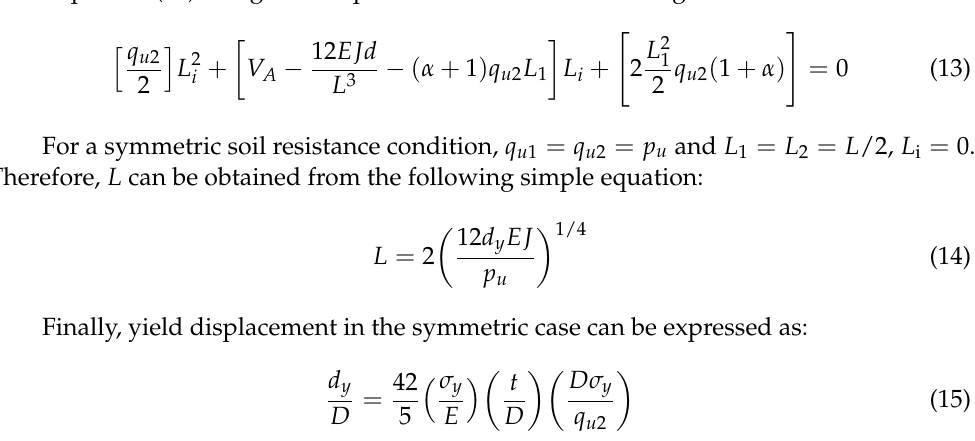
[10]. Figure 3. F ( a ) curve with respect to length ratio α 𝛼𝛼